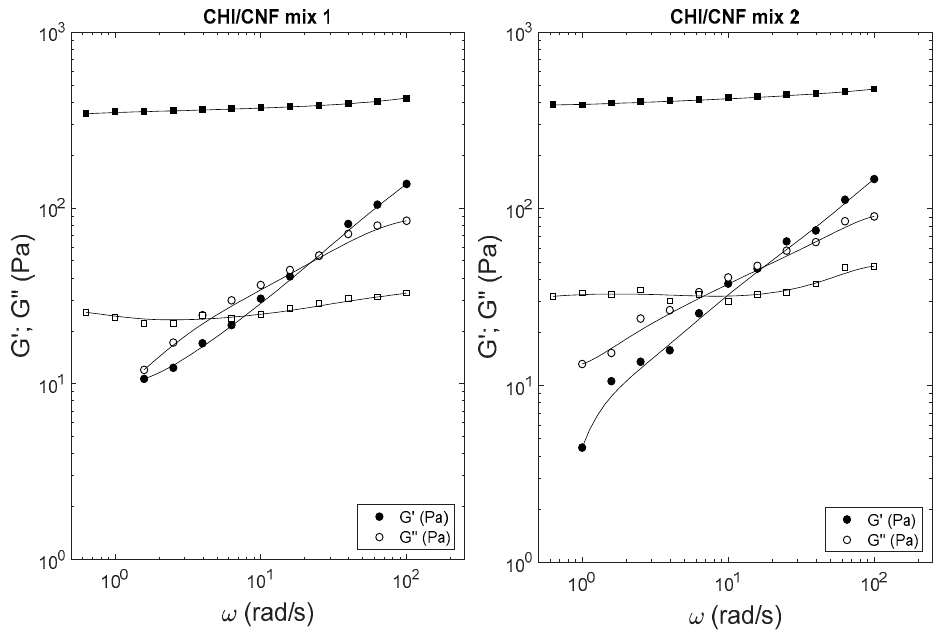
Figure 5. Viscoelastic properties of CHI/CNF associations obtained from mixtures 1 and 2 (Table 1) as G ’; G ” sweeps of angular frequency ω : Samples were characterized after mixing of salted solutions and suspensions (circles) (G’: ● ; G”: ○ ) and after multistep dialysis and gelation in NaOH 1 M (squares) (G’: ■ ; G”: □ ).